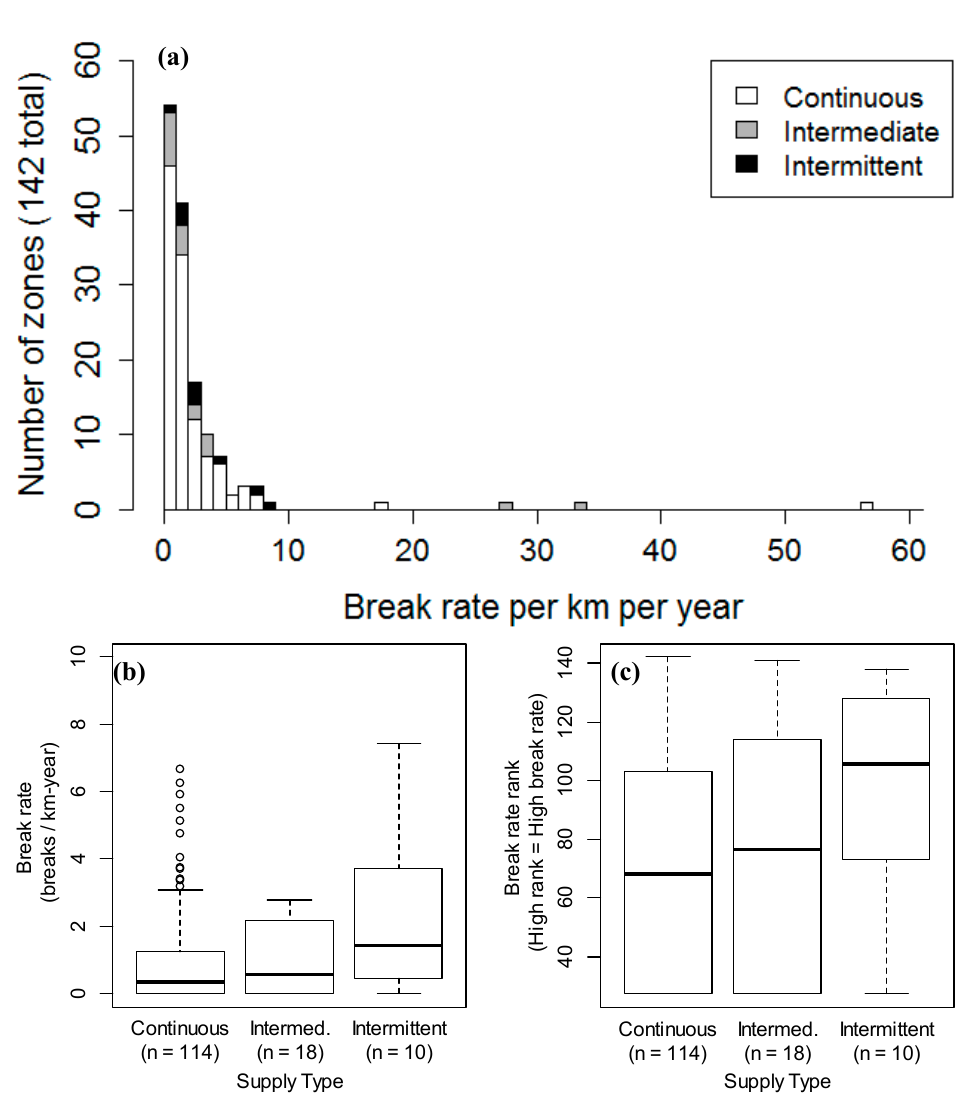
Figure 7. Analysis of 2012-14 pipe break data: ( a ) Distribution of break rates for each zone, ( b ) boxplots of break rate by supply type, and ( c ) and break-rate rank by supply type. In plot ( a ), the first bar (on the far left) represents the 54 zones with no breaks. Four zones with break rates > 10 breaks/km-year are excluded from the plot ( b ). Note that the minimum rank in ( c ) is 27.5 because 54 zones had no breaks and were each assigned an average rank.